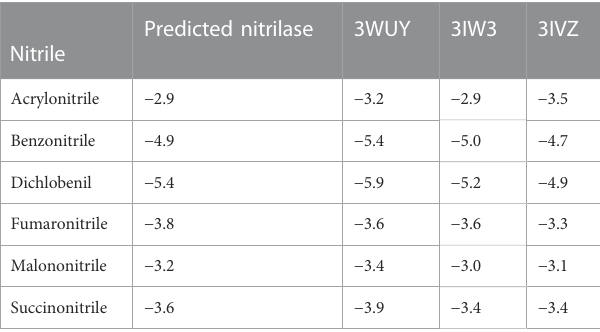
TABLE 1 Docking scores of proteins binding with ligands.